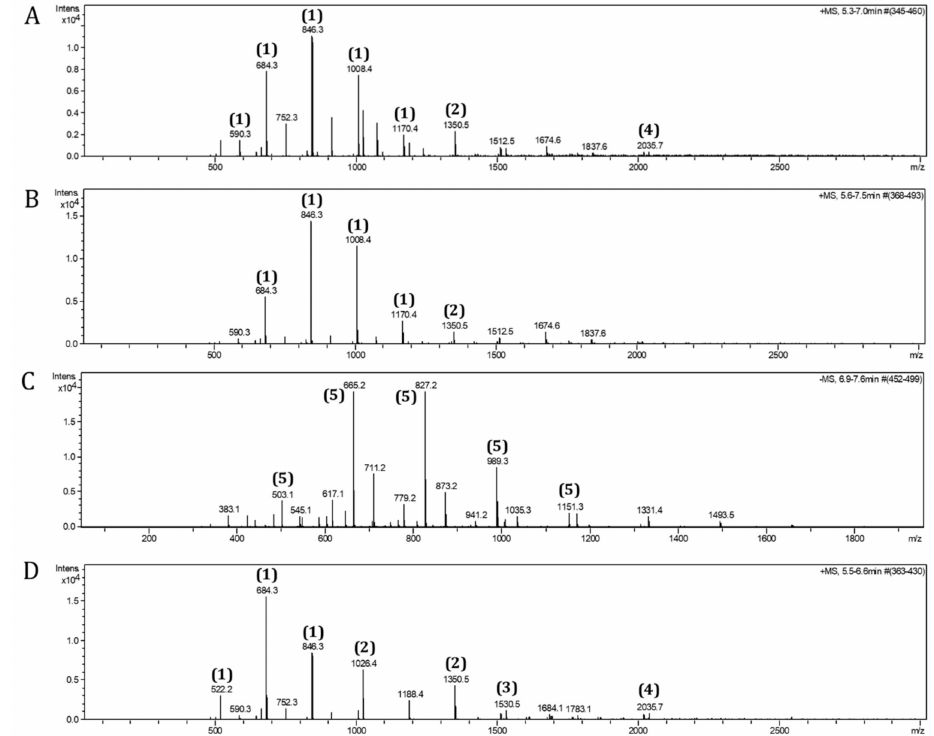
Figure 1. Electrospray ionization-mass spectrometry (ESI-MS) spectra of DP fractions. GOS DP oligomers were separated by size-exclusion chromatography from GOS mixture. The profiles of GOS ( A ), GOS DP4-7 ( B ), GOS DP3-7 ( C ), and GOS DP3-5 ( D ) are shown as ammonia